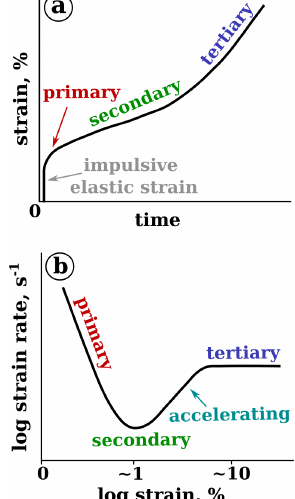
Figure 1. Plots adapted from Budd and Jacka (1989) and Durham et al. (2010) showing the primary, secondary, and tertiary stages of creep with respect to (a) strain over time and (b) strain rate over strain in a constant-load